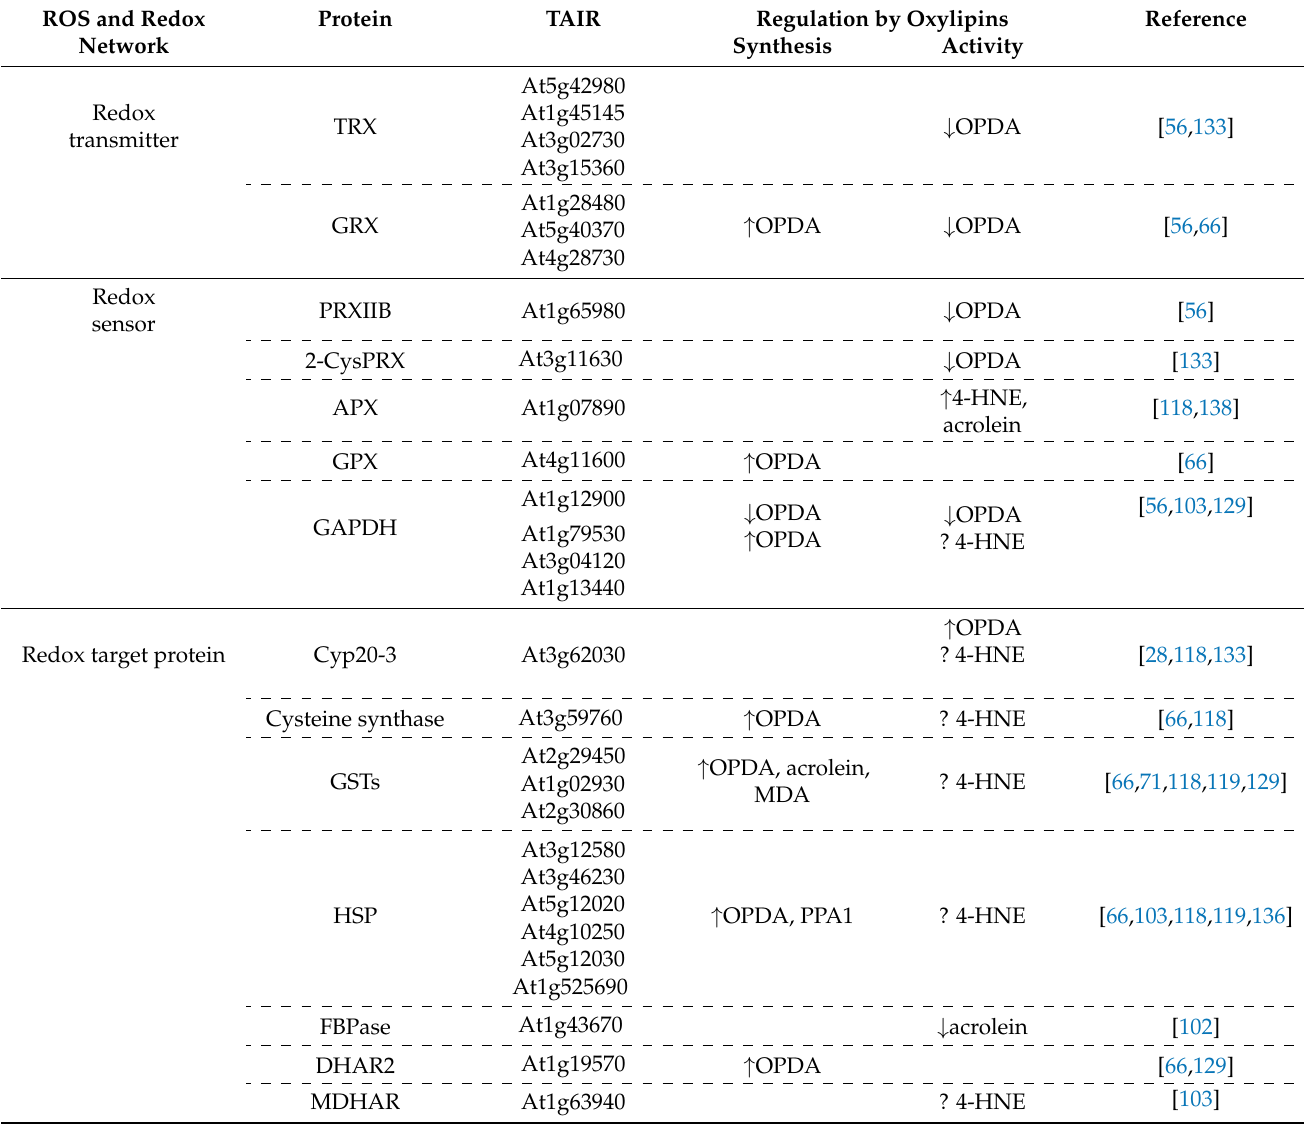
Table 1. Interaction of oxylipins with proteins of ROS synthesis/scavenging and the redox network. Oxylipins modulate protein amounts of the redox network as well as their catalytic activity. Affected proteins include essential proteins of different functional categories of the redox network, such as TRXs as redox transmitter, as well as ROS scavenging enzymes such as peroxidases. Stimulatory effects of oxylipins on protein synthesis/activity is denoted as “ ↑ ”, inhibitory effects as “ ↓ ” and not yet characterized effects of detected oxylipin binding as